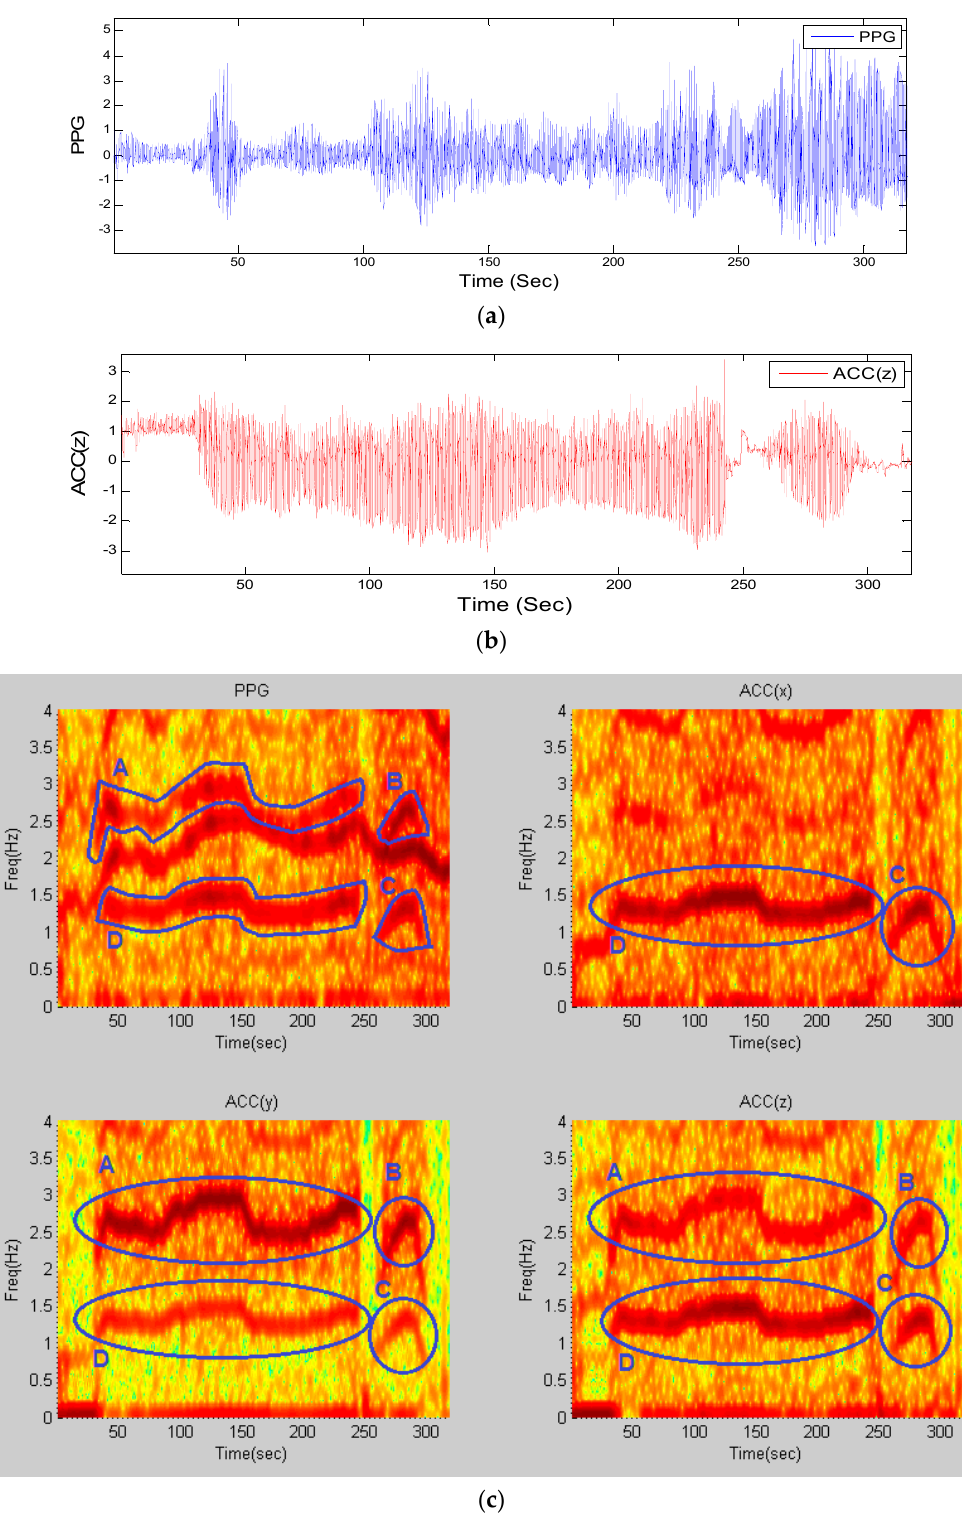
Figure 1. Time-frequency spectra of recording #8 from dataset (1): ( a ) PPG signal; ( b ) simultaneous Accelerometer-Z signal; ( c ) ( Top-Left ) TF spectrum of PPG; ( Top-Right ) TF spectrum of ACC(x); ( Bottom-Left ) TF spectrum of ACC(y); ( Bottom-Right ) TF spectrum of ACC(z); all computed from stage (1) of the algorithm. Blue circles and letters represent movement elements in all four spectra.